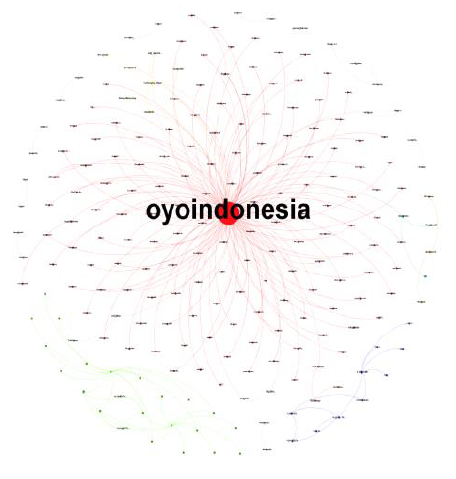
Figure 3: Visualization of OYO Social